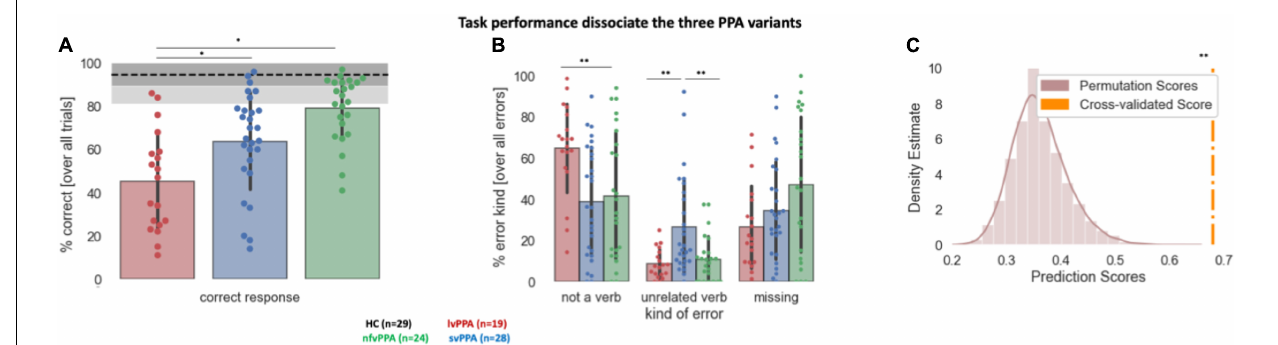
FIGURE 2 | Behavioral performance during the auditory verb generation task. (A) Overall accuracy (% correct responses) across the three PPA variants. The dotted line denotes healthy controls (HC) average, the dark gray shaded area HC standard deviation, and the light gray area the full range of HC data. (B) Percentage of each error type across the three PPA variants. Error bars indicate standard deviation. Each dot represents a patient. Asterisk(s) denote(s) significant differences at ** p < 0.01, * p < 0.05. (C) Results of the machine learning algorithm trained to classify the participants in the correct diagnostic group. The density distribution of the permutation scores is shown in light brown, the cross-validated score in orange. ∗∗ Denotes the significant cross-validated score ( p < 0.001).